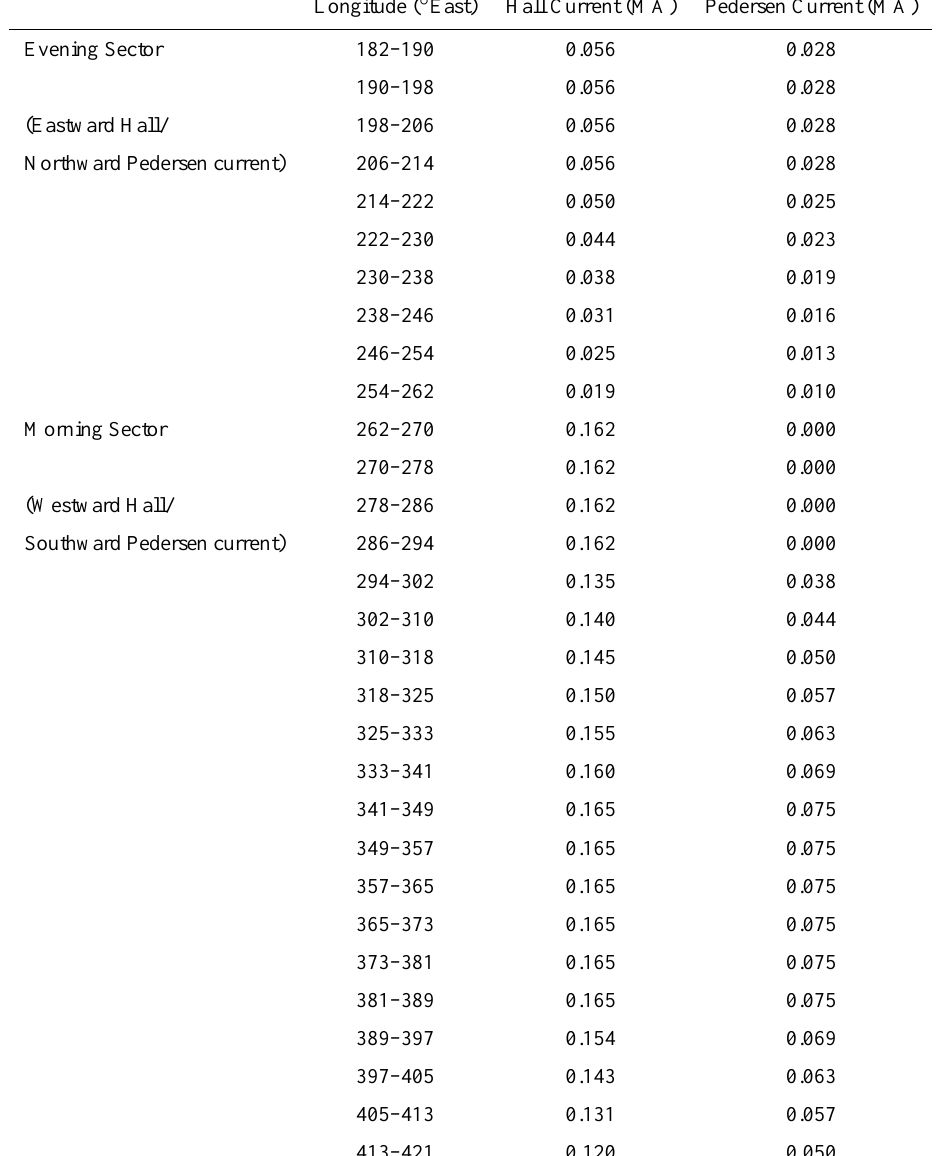
Table 2. Current magnitudes for Post-onset model.